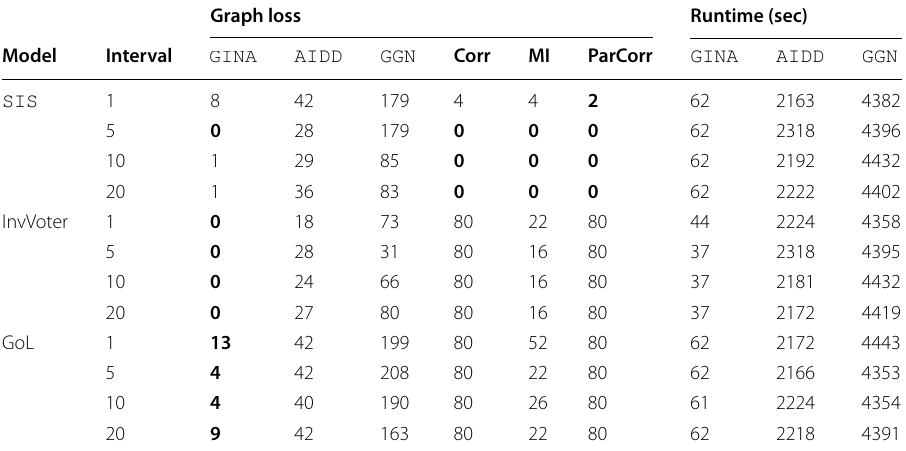
Table 2 Exp. 3 : [Lower is better.] Results of different graph inference methods on time series data